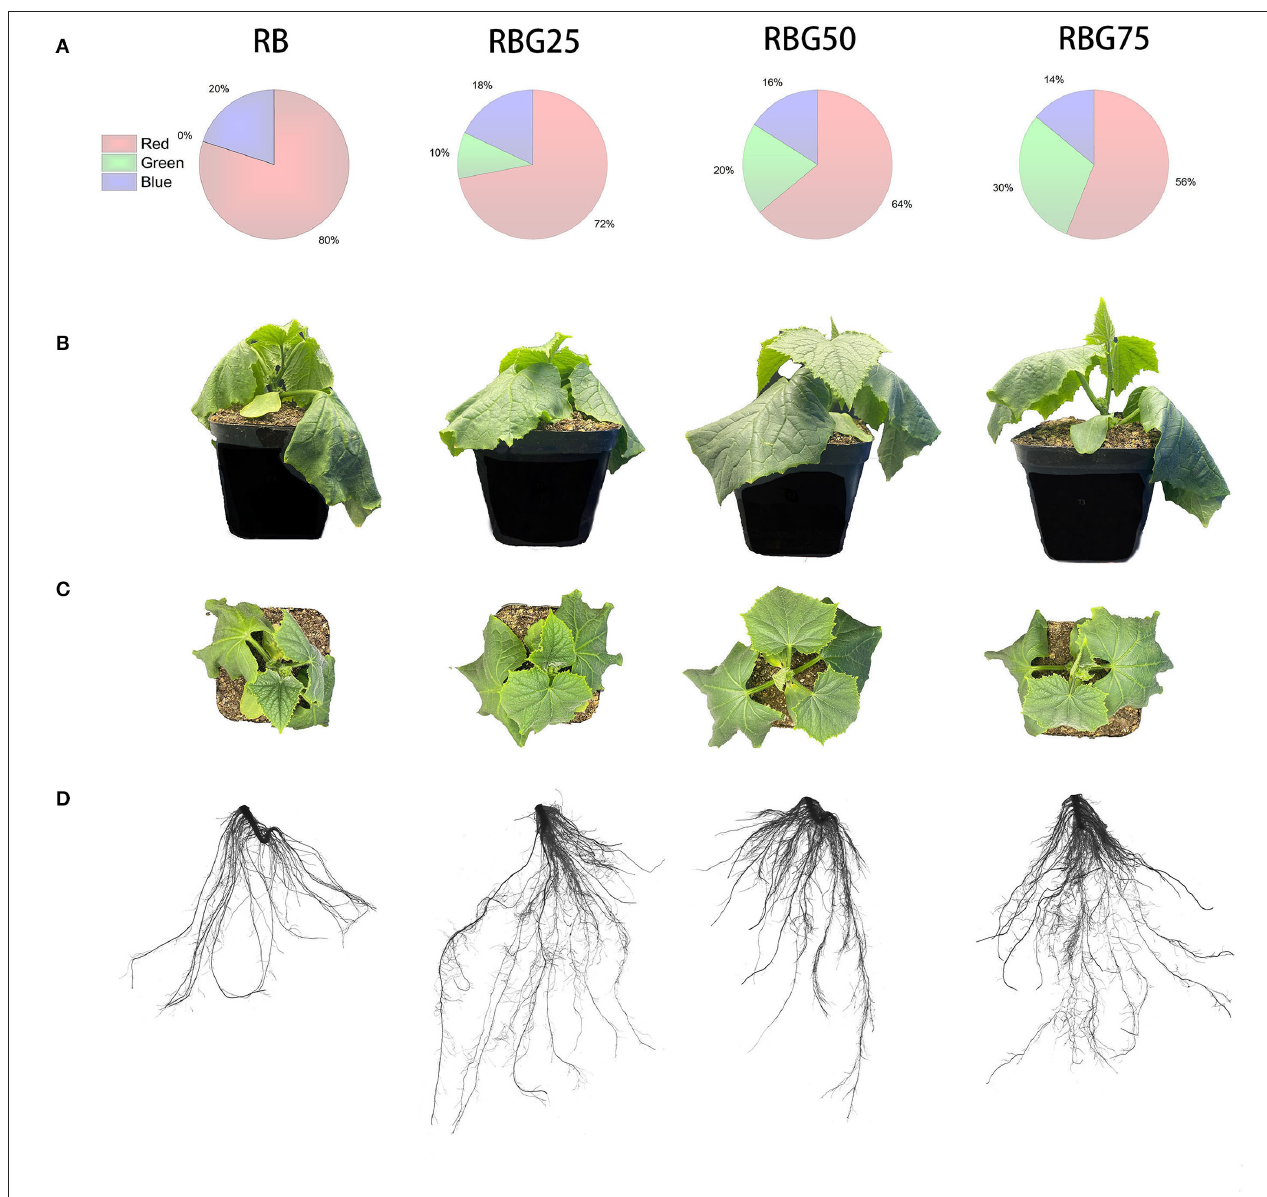
FIGURE 2 | Morphology parameters of cucumber seedlings under different treatments after 9 days drought stress. (A) Different spectral conditions include RB, RBG25, RBG50, and RBG75. The different colors represent different light qualities in disc figures. (B) Front view of cucumber plants. (C) Top view of cucumber plants. (D) Root scanned images of cucumber plants. RB, RBG25, RBG50 and RBG75 are the different spectral conditions, respectively. The PPFD for all the treatments was 250 µ mol m − 2 s − 1 . Representative plants were chosen based on plant dry weight and height closest to the average of the treatment. This image is a composite to allow for visual comparison between